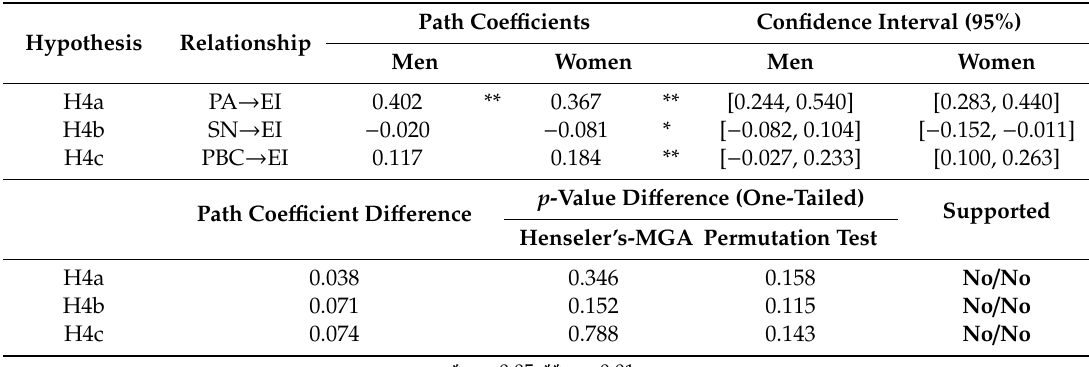
Table 9. Multigroup analysis by